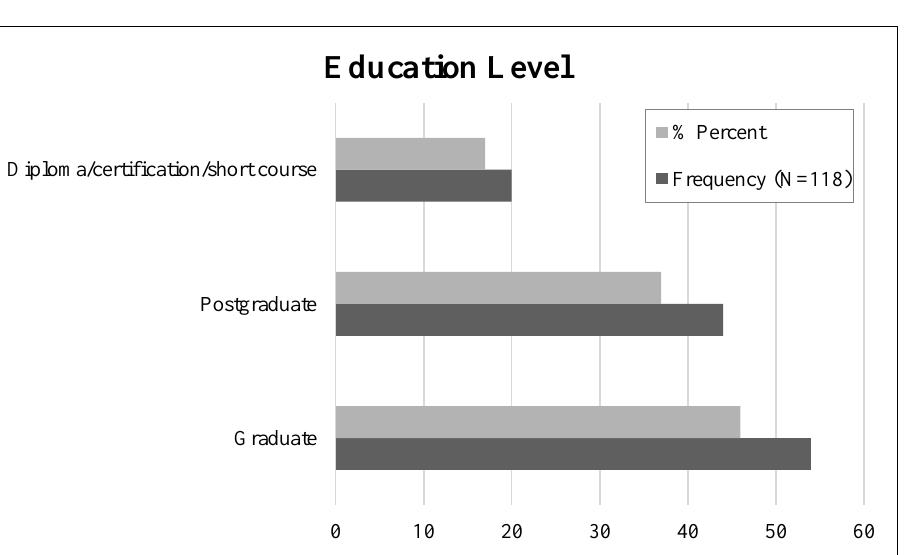
Figure 4. Educational level of the participants